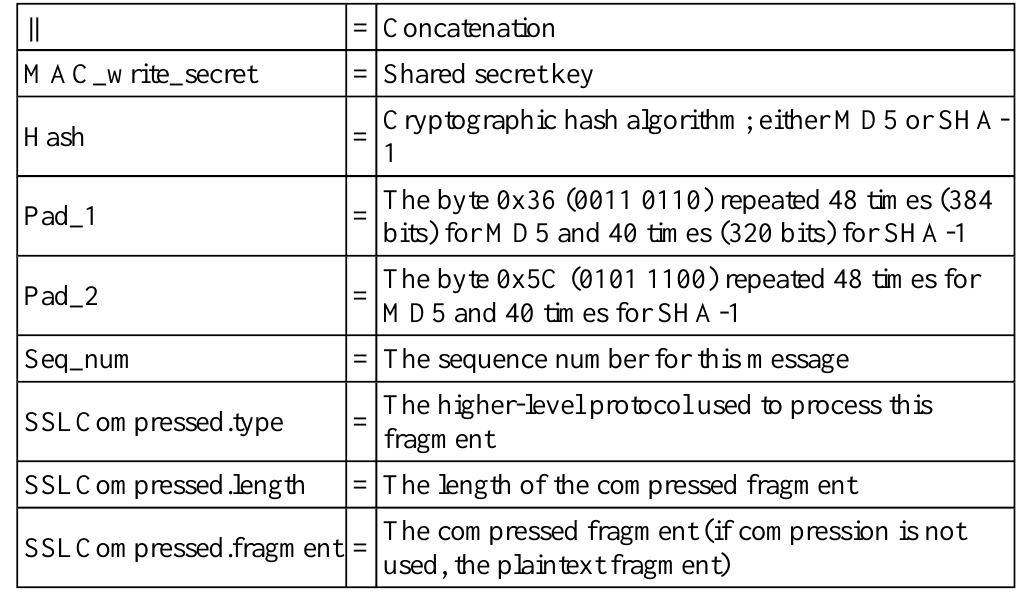
Table 2 How to understand the message authentication